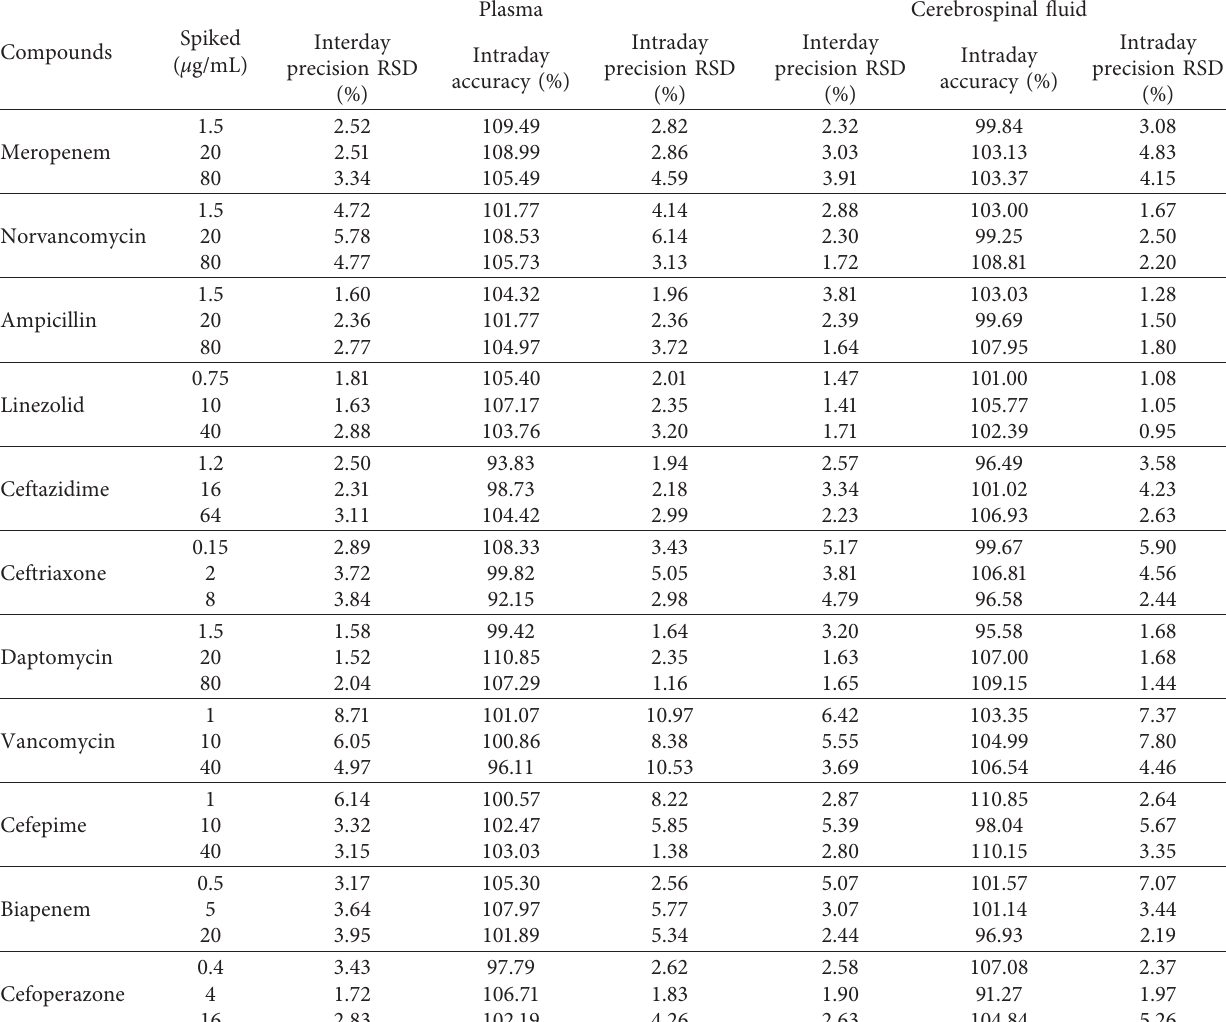
Table 3: Precision and accuracy for 14 antibiotics in human plasma and cerebrospinal fluid ( n � 6).